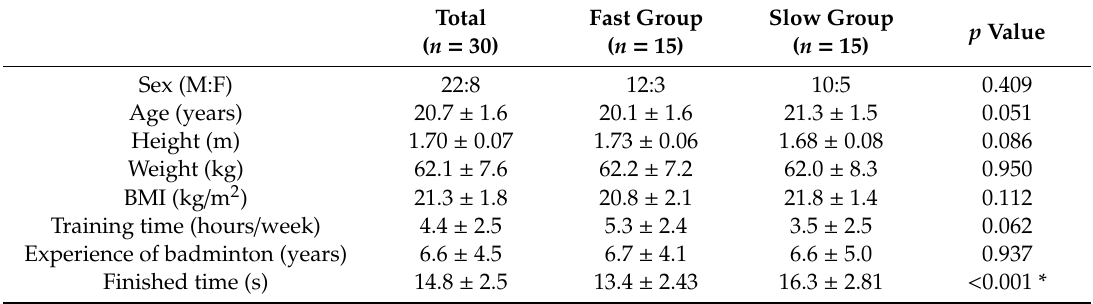
Table 1. Descriptive data of participants. Mean ± standard